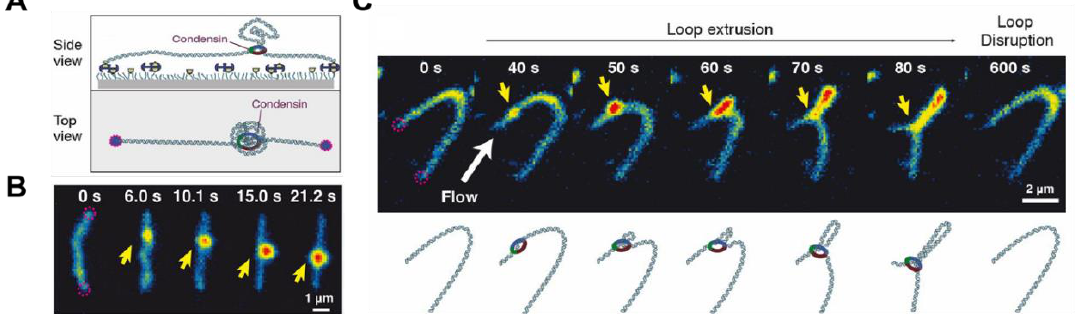
Figure 4. Fluorescence imaging of DNA loop extrusion by condensin. ( A ) Single-molecule assay for the visualisation of condensin-mediated DNA looping. ( B ) Snapshots showing DNA loop extrusion intermediates created by condensin on a SxO-stained doubly tethered λ-DNA. The yellow arrow indicates the location of the loop base. ( C ) Snapshots showing the gradual asymmetric extension of a DNA loop (yellow arrow) on a doubly tethered λ-DNA molecule (reproduced with permission from [73]).